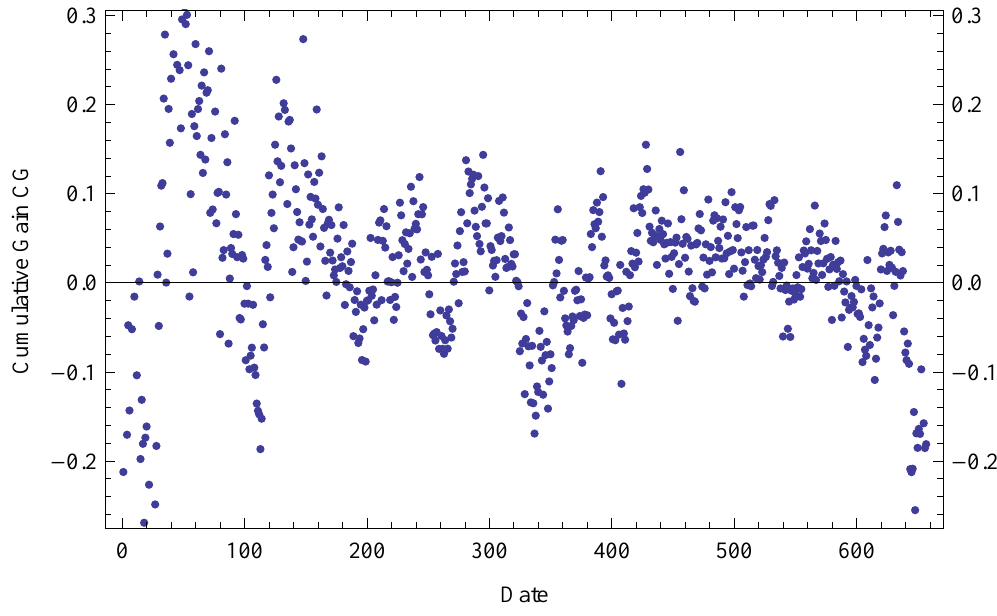
Figure 14. Gain realized by picking the top 10 tickers chosen from the snapshot aggregation algorithm and selling after 20 days.